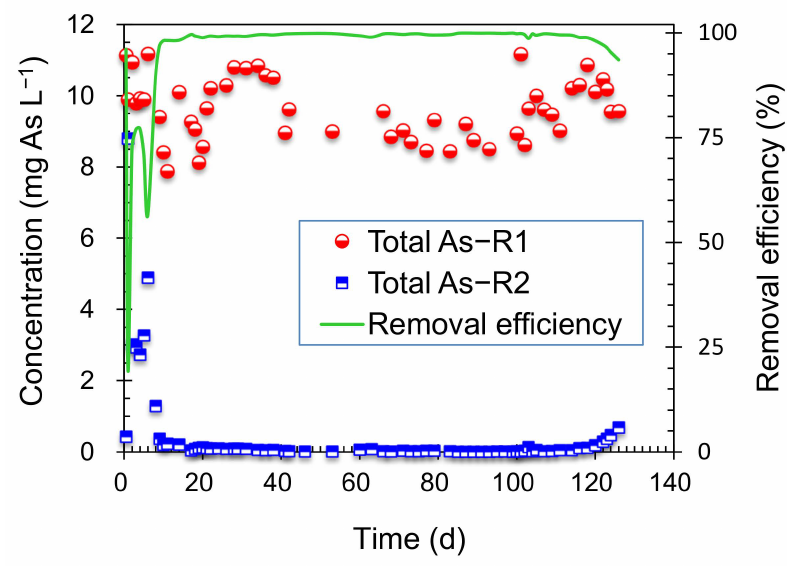
Figure 2. Total As removal by the combined